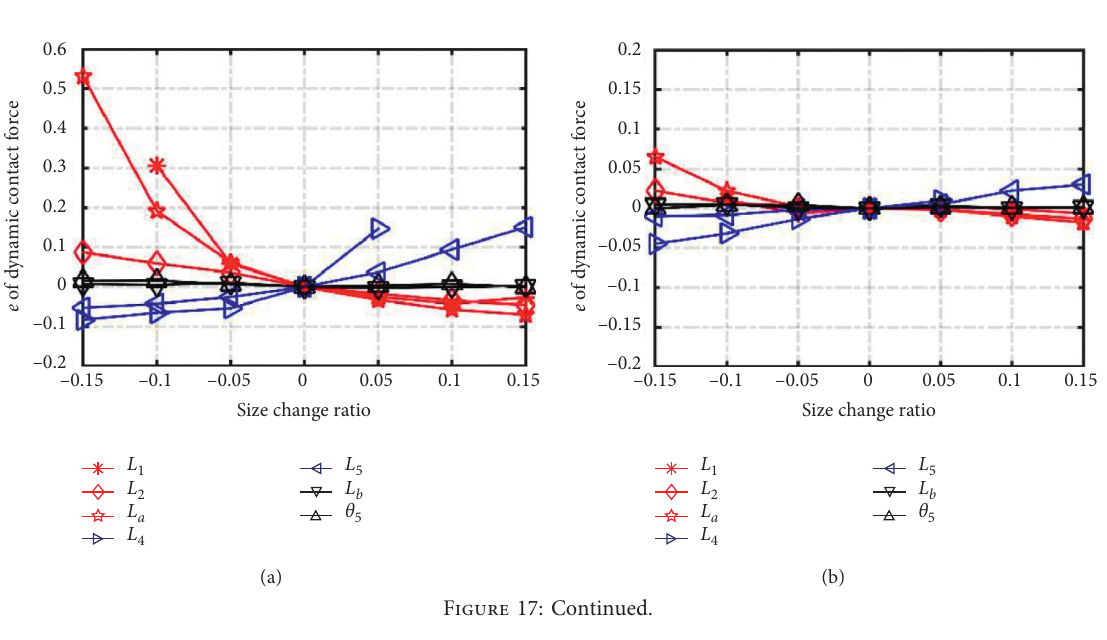
Figure 16: STD of the dynamic contact force: (a) variation of L 15%); (d) variation of L a ; (e) variation of L b ; (f) variation of L 5 ; (g) variation of θ 5 .